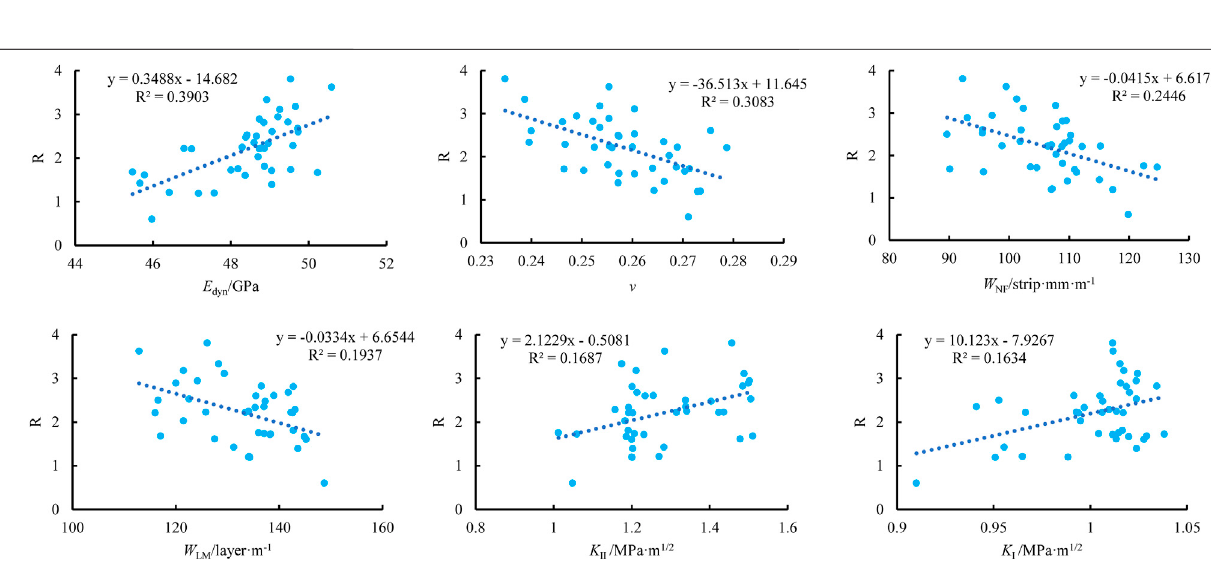
Frontiers in Earth Science |